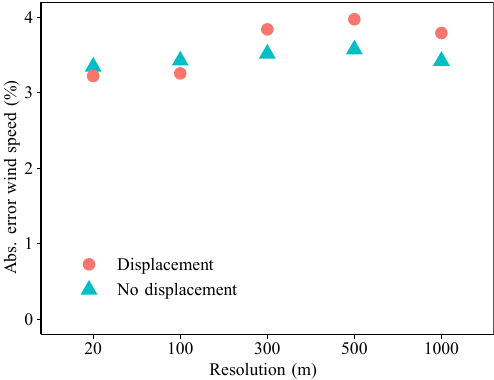
Figure 7. Ratio between the mean absolute error in wind speed and the mean absolute error without taking into account any rough- ness changes ( | δU | / | δU 0 | ) as a function of the number of significant roughness changes n .